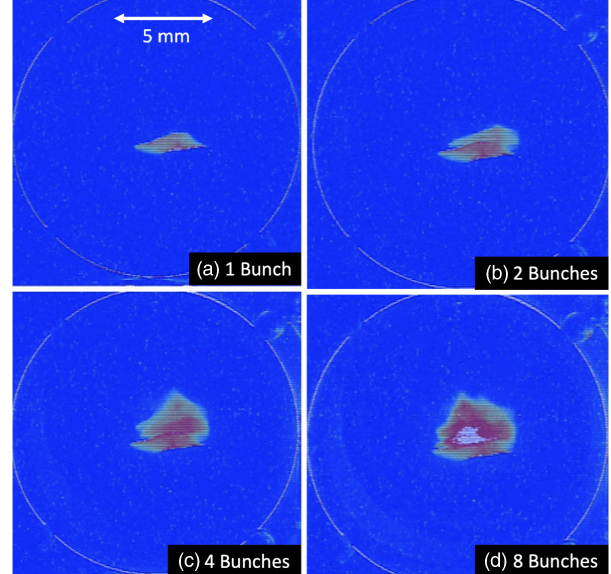
FIG. 22. YAG images taken before (upstream from) the power extractor show an bunch-to-bunch offset that is on the order of the bunch diameter. This is believed to be due to undamped trans- verse wakes in the linear accelerator. The total charge in this bunch train is 230